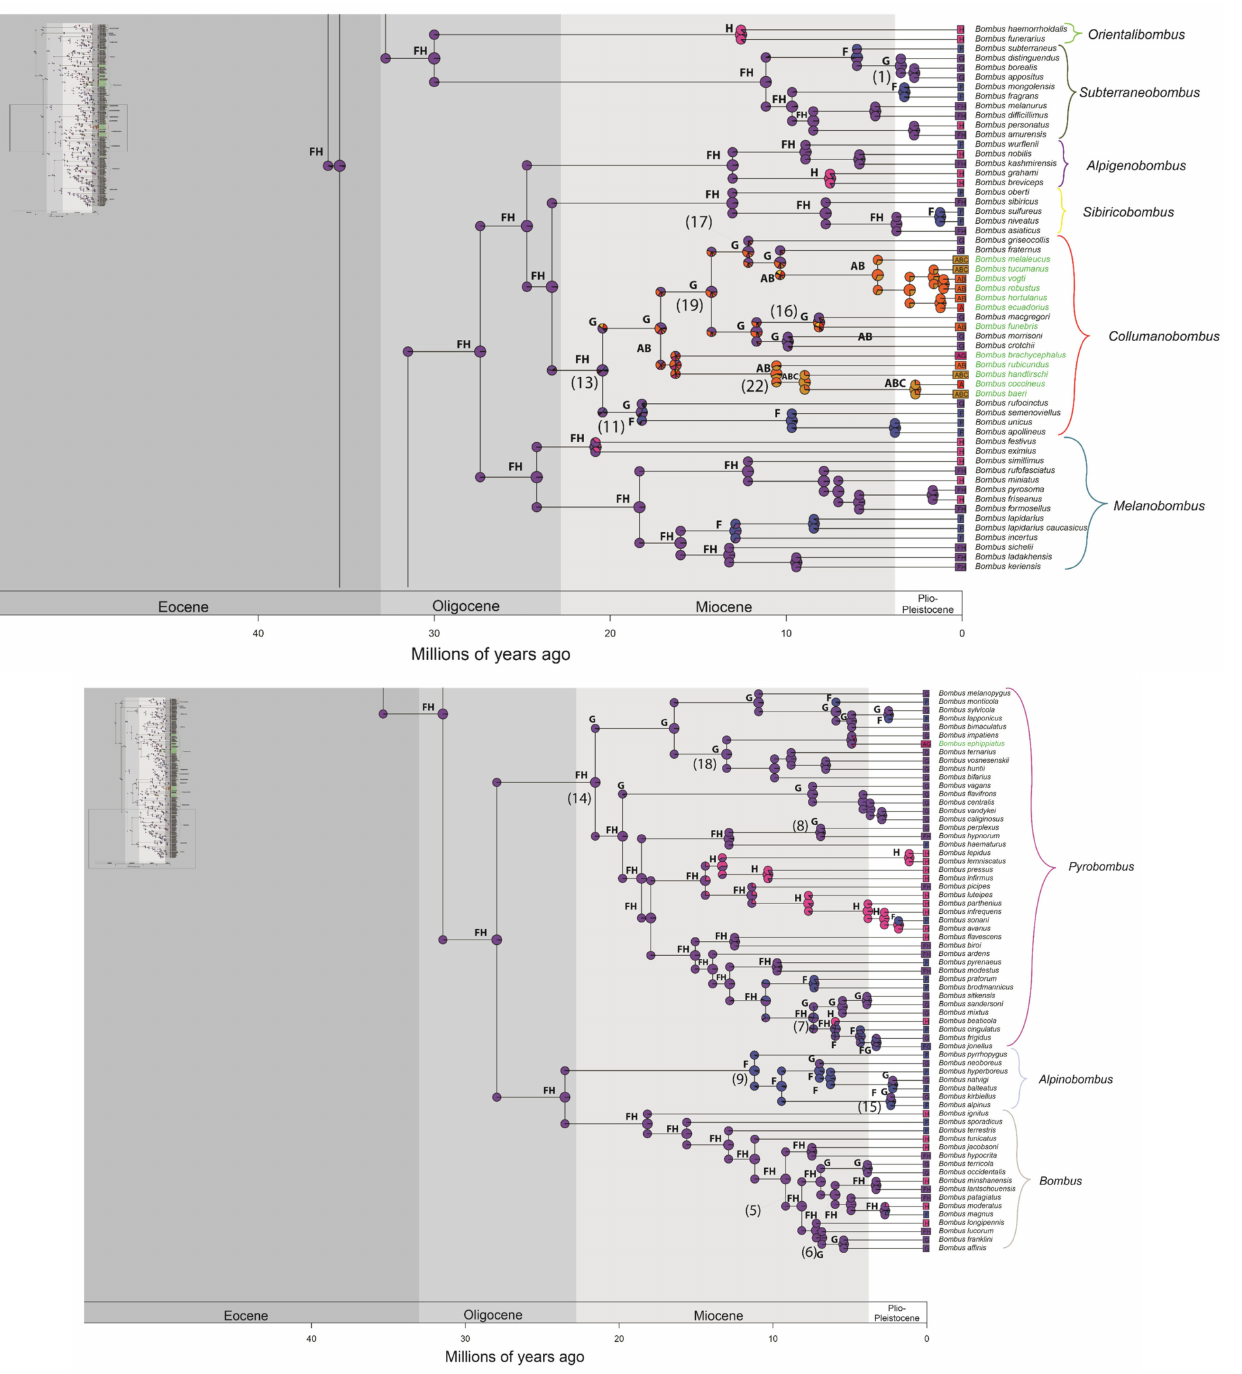
Figure 2. Distribution of occurrence of data for ancestry inference of bumblebee species. Letters correspond to the areas are shown in Figure 1 (A—northern and western regions of the Andes; B—Amazonian region; C—Chaco region; D—Parana region; E—Andean region; F—Palearctic region; G—Nearctic region; H—Oriental region). Numbers in parentheses correspond to the events shown in Figure 3. Node panels show the probability of each geographic state from BioGeoBEARS analysis. Time tree for bumblebees obtained under an uncorrelated lognormal relaxed clock model calibrated with nine fossils (Supplementary File S2—priors for divergence time estimation, and Figure S2). The names of Neotropical bumblebee species are provided in